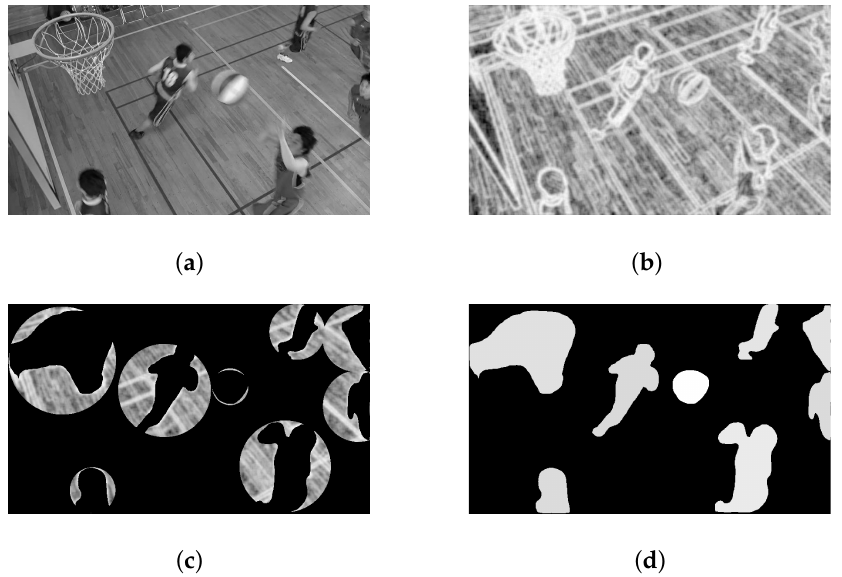
Figure 8. ( a ) The 212th original frame of the “Basketball Drill”; ( b ) The complexity map of the whole frame; ( c ) The contextual complexity map of the semantics; ( d ) The inhibitory effect of contextual complexity on